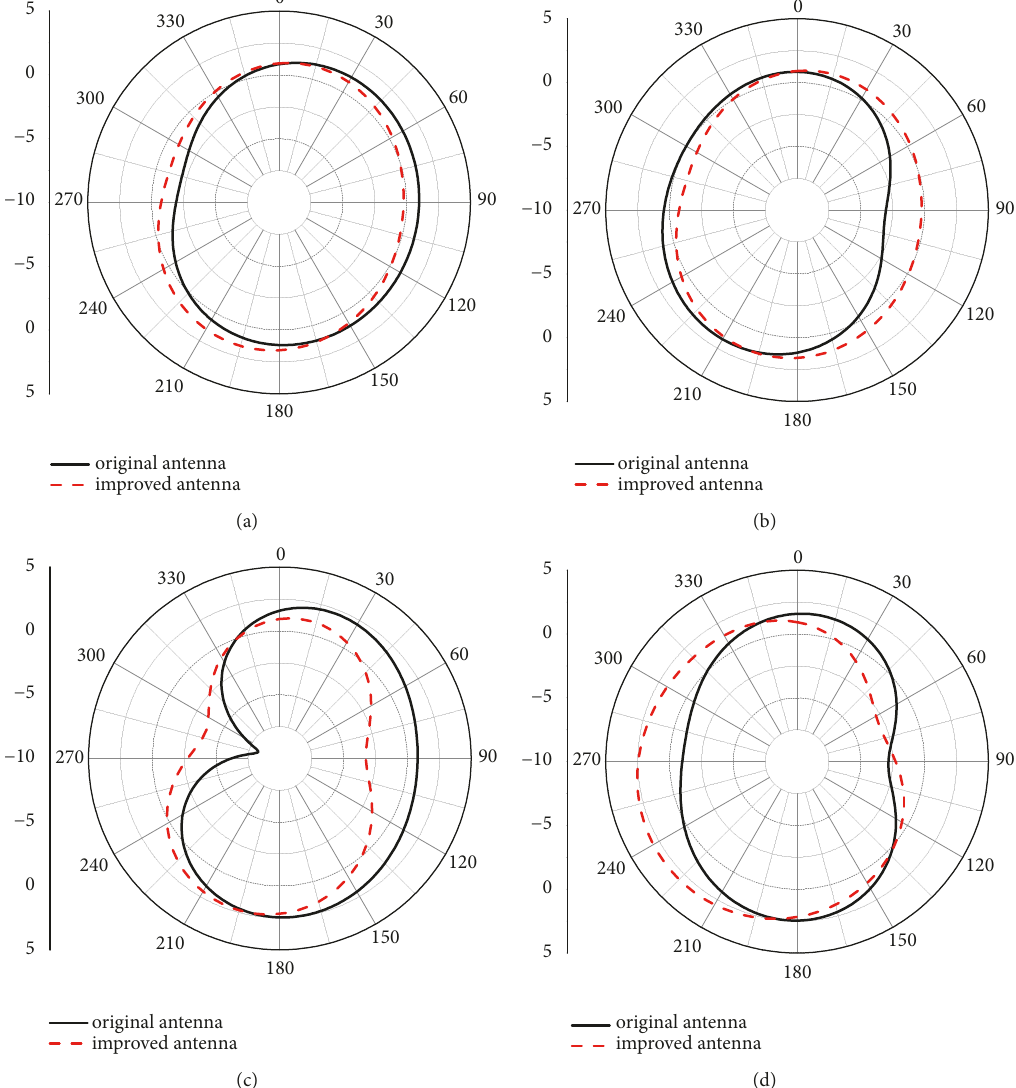
Figure 7: Simulated radiation pattern. (a) E plane and (b) H plane at 3.52 GHz; (c) E plane and (d) H plane at 4.9